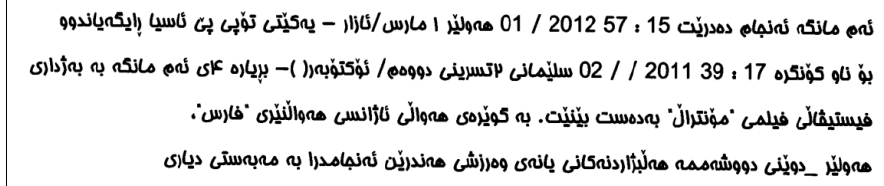
Figure 9. A Sample of Synthetic Data for Unikurd_Tishk font.